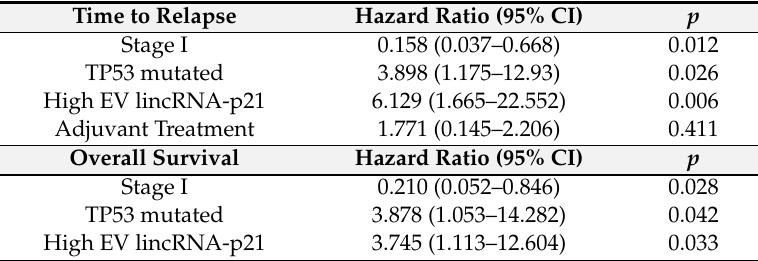
Table 2. Multivariate analysis for time to relapse and overall survival. CI, confidence interval; EV, extracellular